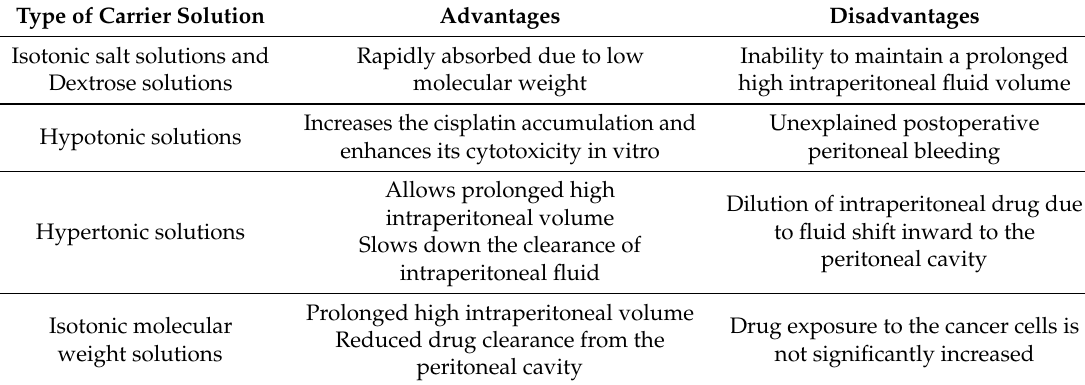
Table 2. Types of carrier solutions (adapted from Kusamura et al. (2008) [26]).